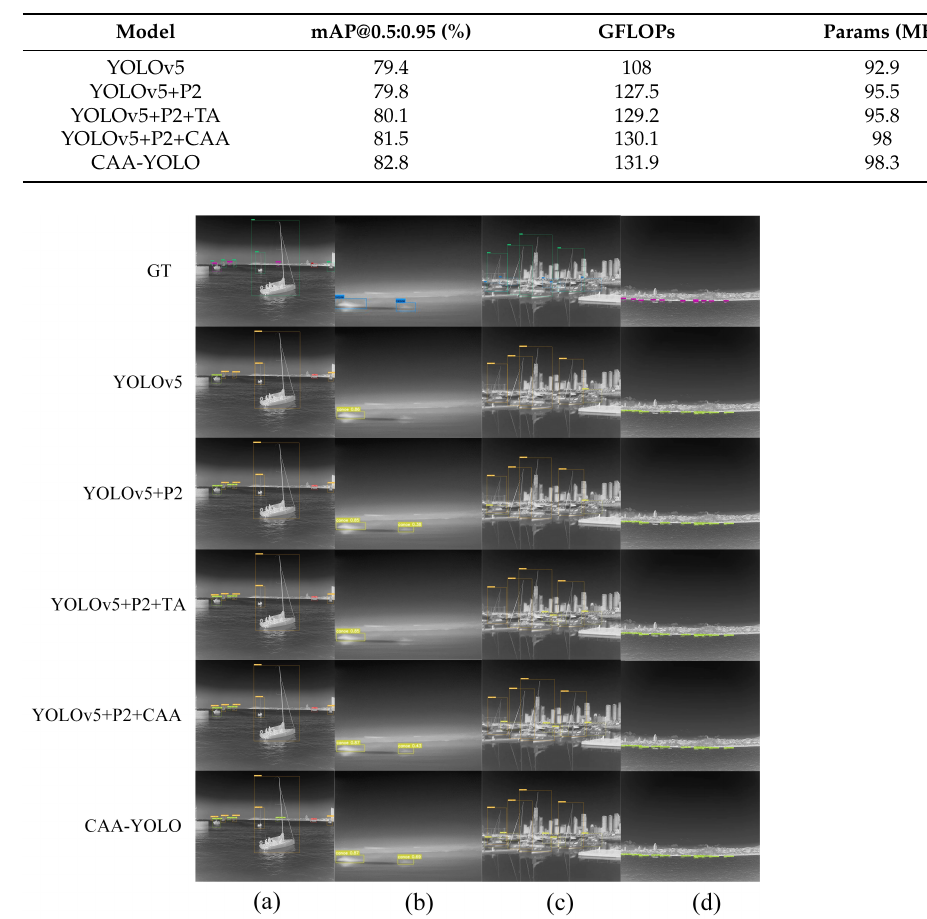
Table 8. Experimental results of different optimization strategies.